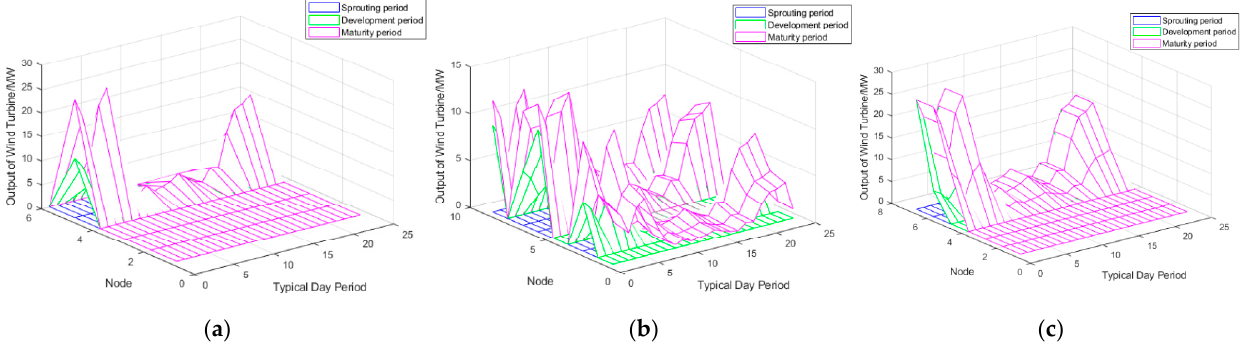
Figure 5. Output of wind turbine at each typical stage of the system: ( a ) transmission network; ( b ) distribution network 1; ( c ) distribution network 2.